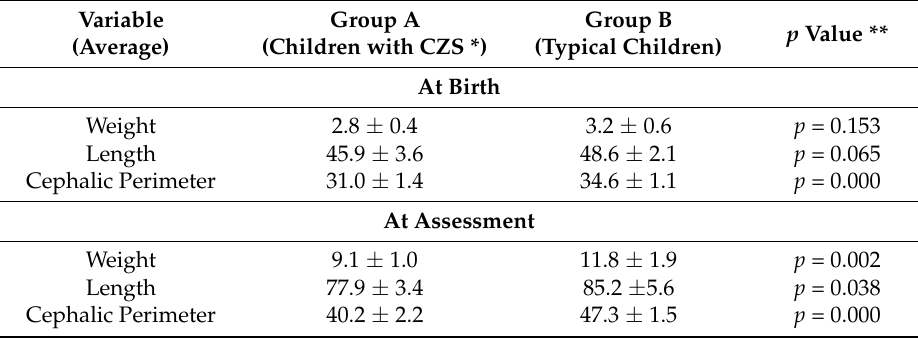
Table 2. Average, standard deviation, and significant differences between groups in relation to infant growth (n =